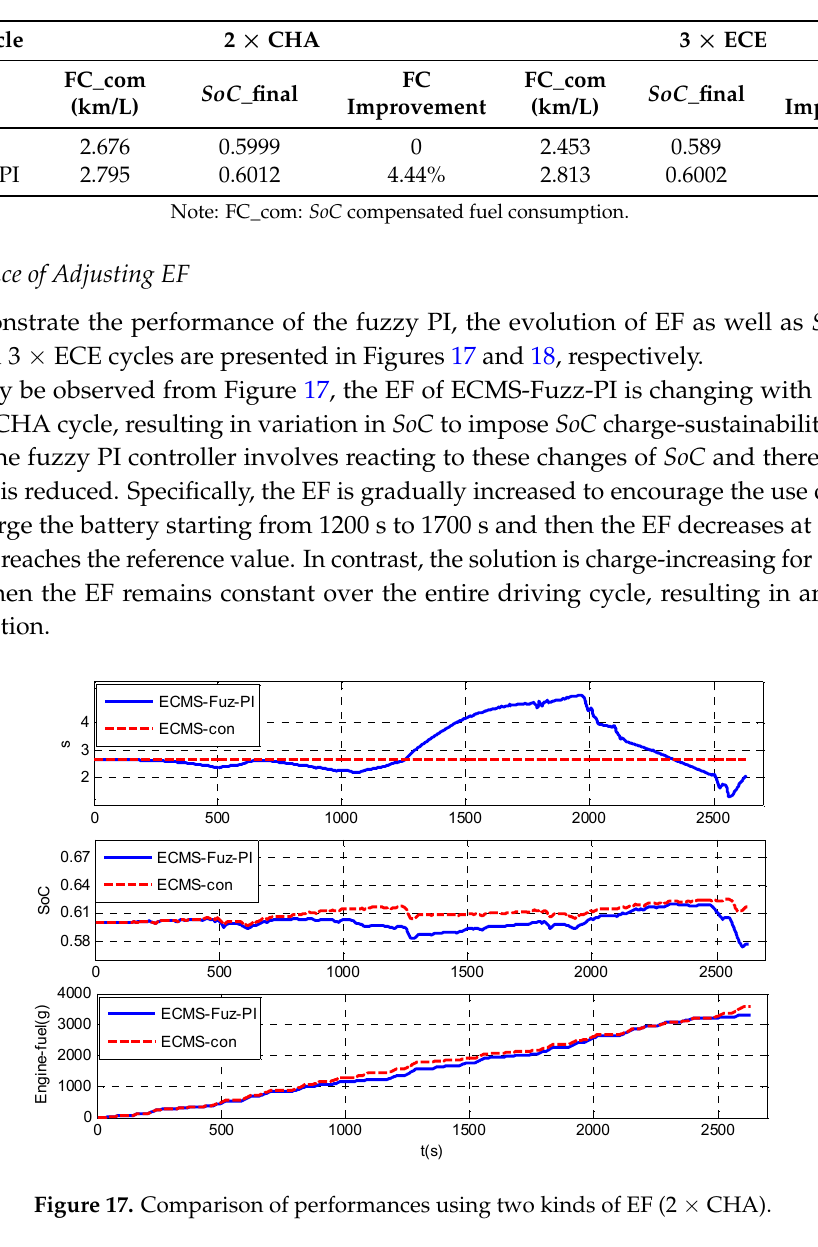
Table 5. Comparison of different control strategies.